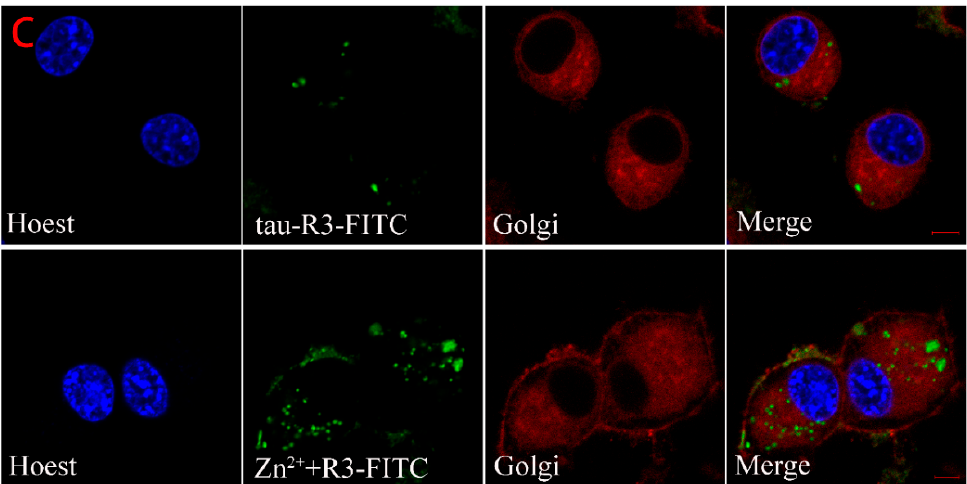
Figure 8. Cellular localization of tau-R3 and Zn 2+ -tau-R3 in N2A cells. The final concentrations of tau-R3 and Zn 2+ are 7.5 μ M and 3.5 μ M. Nuclei stained with Hoechst, plasma membrane stained with Dil-Tracker Red ( A ), endoplasmic reticulum stained with ER-Tracker Red ( B ), and Golgi complex stained with Golgi-Tracker Red ( C ). The scale bars represent 5 μ m.